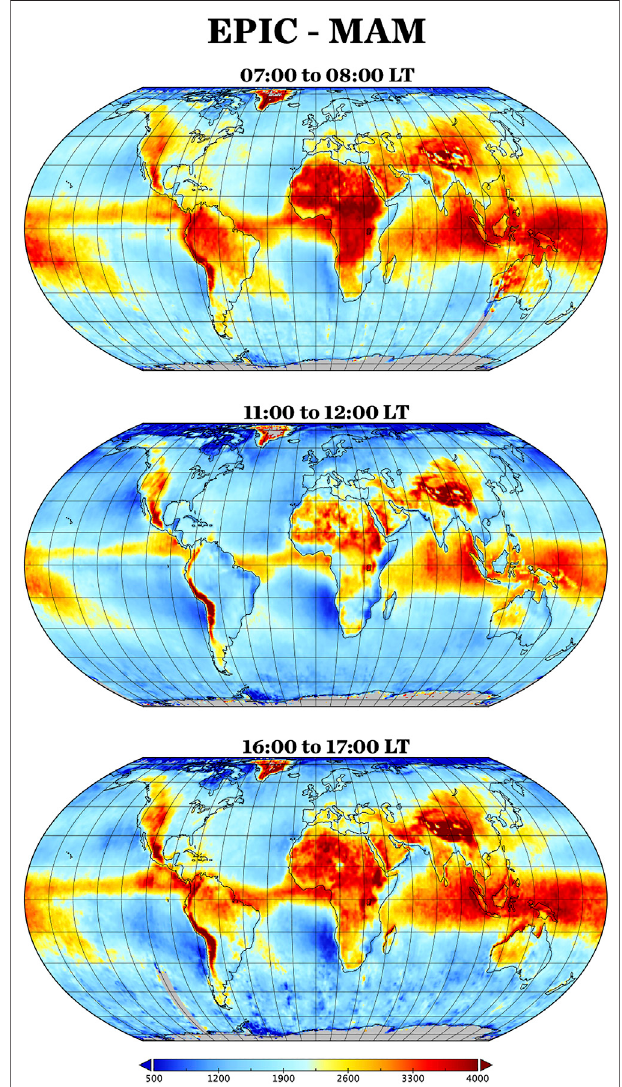
FIGURE 5 | EPIC cloud height for liquid clouds in meters at three selected times for Boreal spring.